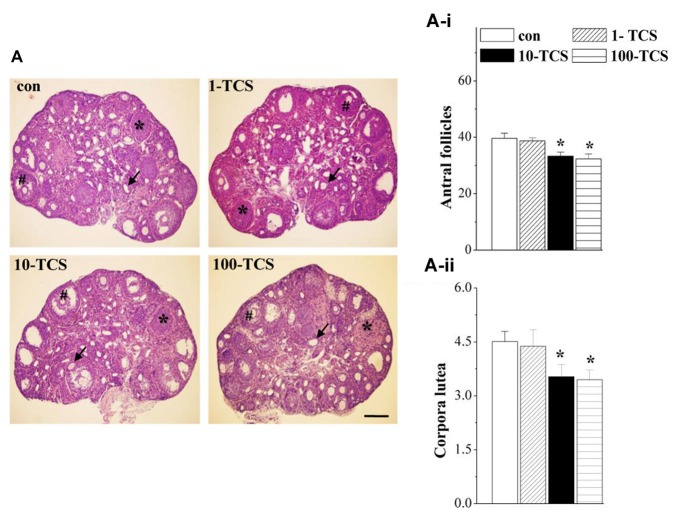
TCS affects follicle development and ovulation. (A) Representative images of ovaries stained with hematoxylin and eosin (HE) in control mice and TCS mice. #: antral follicles; ↑: atretic follicles; *: corpora luteum. Scale bars = 200 μm. (A-i,A-ii) Bar graphs represent the mean number of antral follicles and corpora luteum at diestrus, respectively. *P < 0.05 vs. control mice (one-way ANOVA).